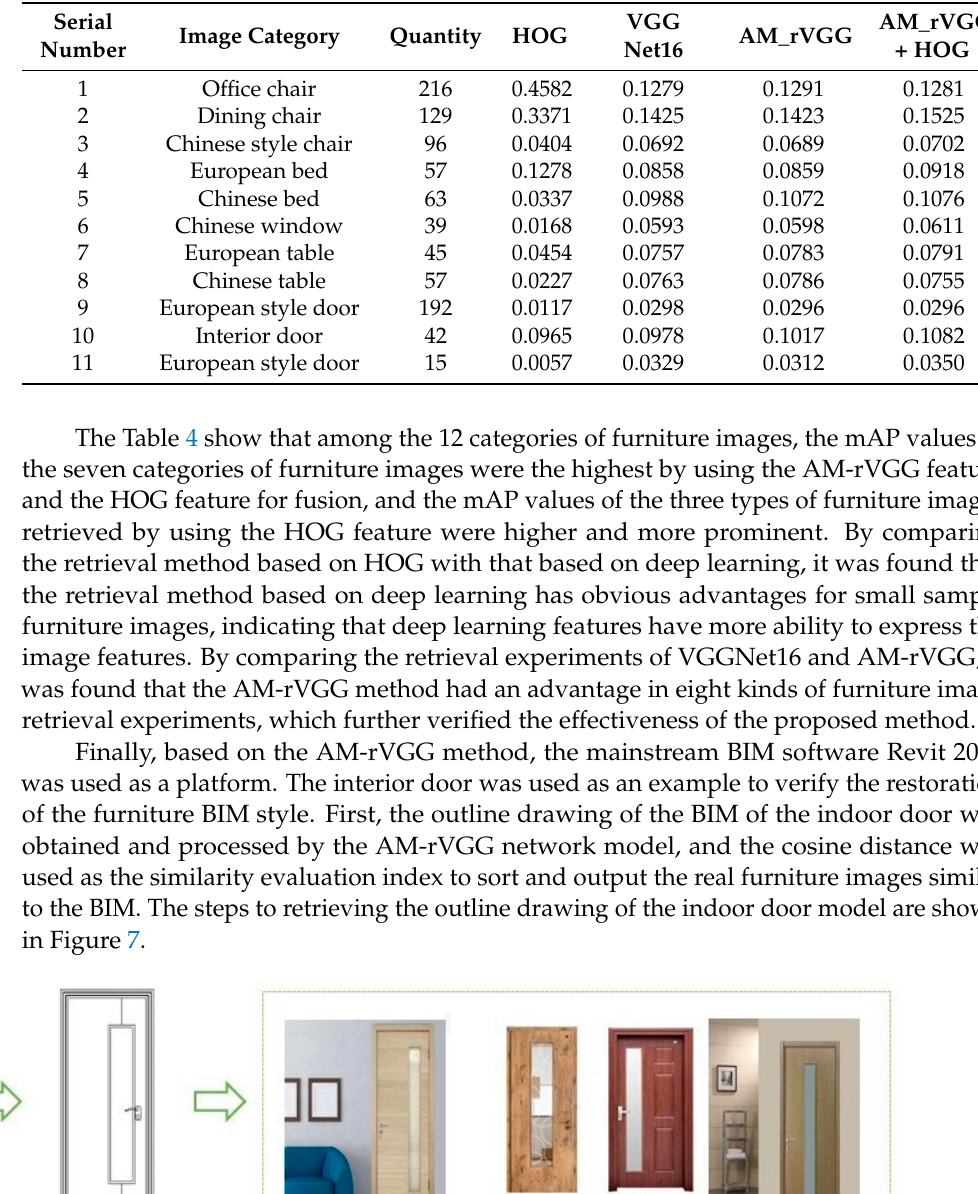
Table 4. mAP values for the different types of furniture.